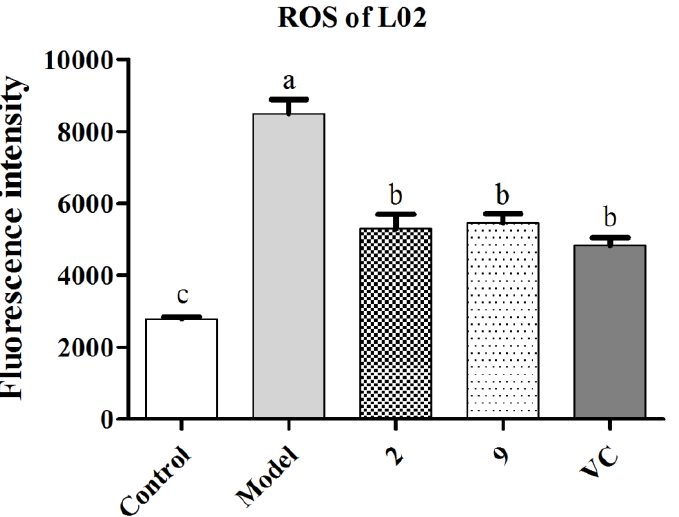
Figure 9. ROS production quantitation of compounds 2 and 9 at 5 µ M on H 2 O 2 -induced injury in L02 cells. Vitamin C was used as positive control (5 µ M). Data are expressed as means ± SD ( n = 3) and means labeled by different letters (a–c) are significantly different at a level of p < 0.05 ( n = 3) by one-way ANOVA DMRT.